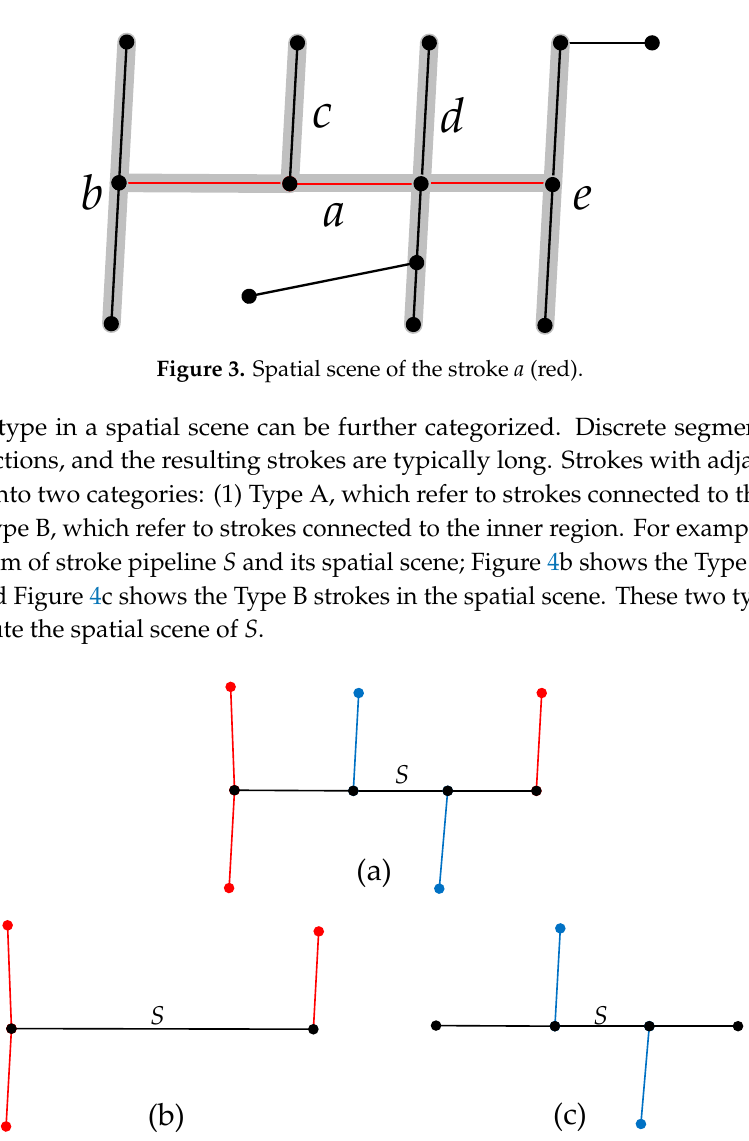
Figure 4. Stroke classification in the stroke spatial scene. ( a ) Shows the spatial scene of S; ( b ) shows the Type A strokes; ( c ) shows the Type B strokes.